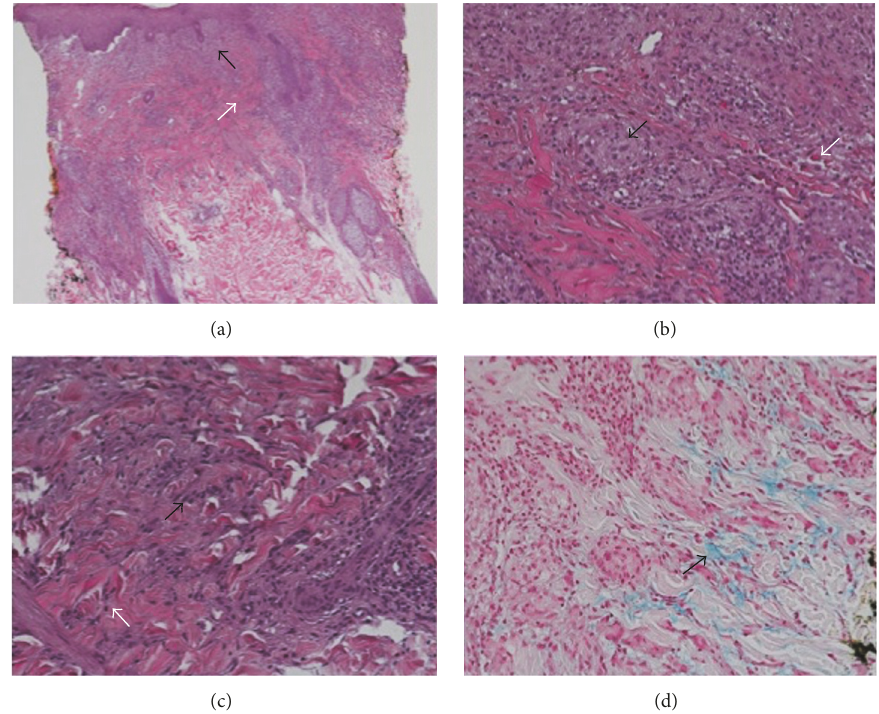
Figure 2: Histopathological slides. At 2x magnification (a), there are superficial periadnexal and interstitial granulomatous infiltrates (black arrow).Theepidermisisslightlyattenuatedwithsubjacentpapillarydermalfibrosis(whitearrow).At20xmagnification,thesuperficialdermis (b) contains well-formed granulomas (black arrow) and individual histiocytes that are scaffolded in between collagen bundles; scattered eosinophils are present (white arrow). In the mid dermis (c), there are numerous interstitial histiocytes in small clusters (black arrow) and solitary units (white arrow). Colloidal iron stain (d) reveals interstitial deposition of dermal mucin (black